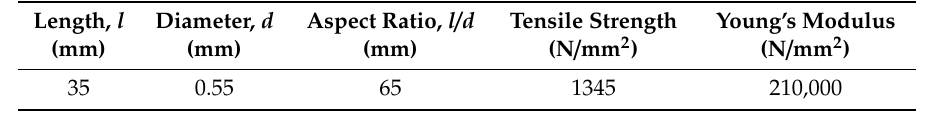
Table 3. Property and geometry of the steel fibres.